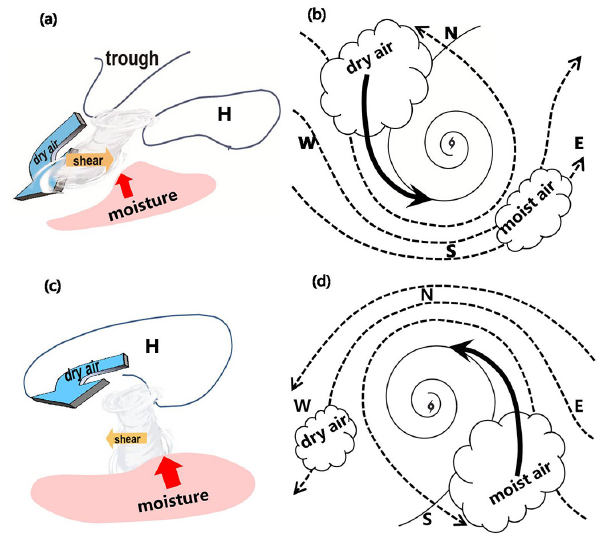
Figure 12. Schematic of the influences of the WNPSH on the inten- sity change of a (top) weakening and (bottom) strengthening TC. “H” in (a) and (c) indicates the WNPSH; in (b) and (d) , the dashed curves denote the westerly and easterly storm-relative environmen- tal flow, respectively. The solid curves roughly indicate the TC’s inner-core-region boundary, and the regions of dry and moist air represent the actual areas of dry or moist air in the earlier compos- ite results. The thick curved arrows indicate the ways the dry or moist air enters the TC circulation. (see text for details).